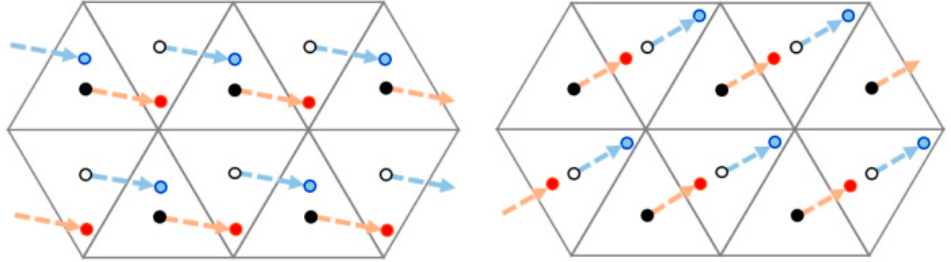
Figure 4. A bijective and a non-bijective translation left and right, respectively. The translation vector is shown. In the case of non-bijective translation, two distinct points have the same image and there are pixels that do not correspond to any original pixel.